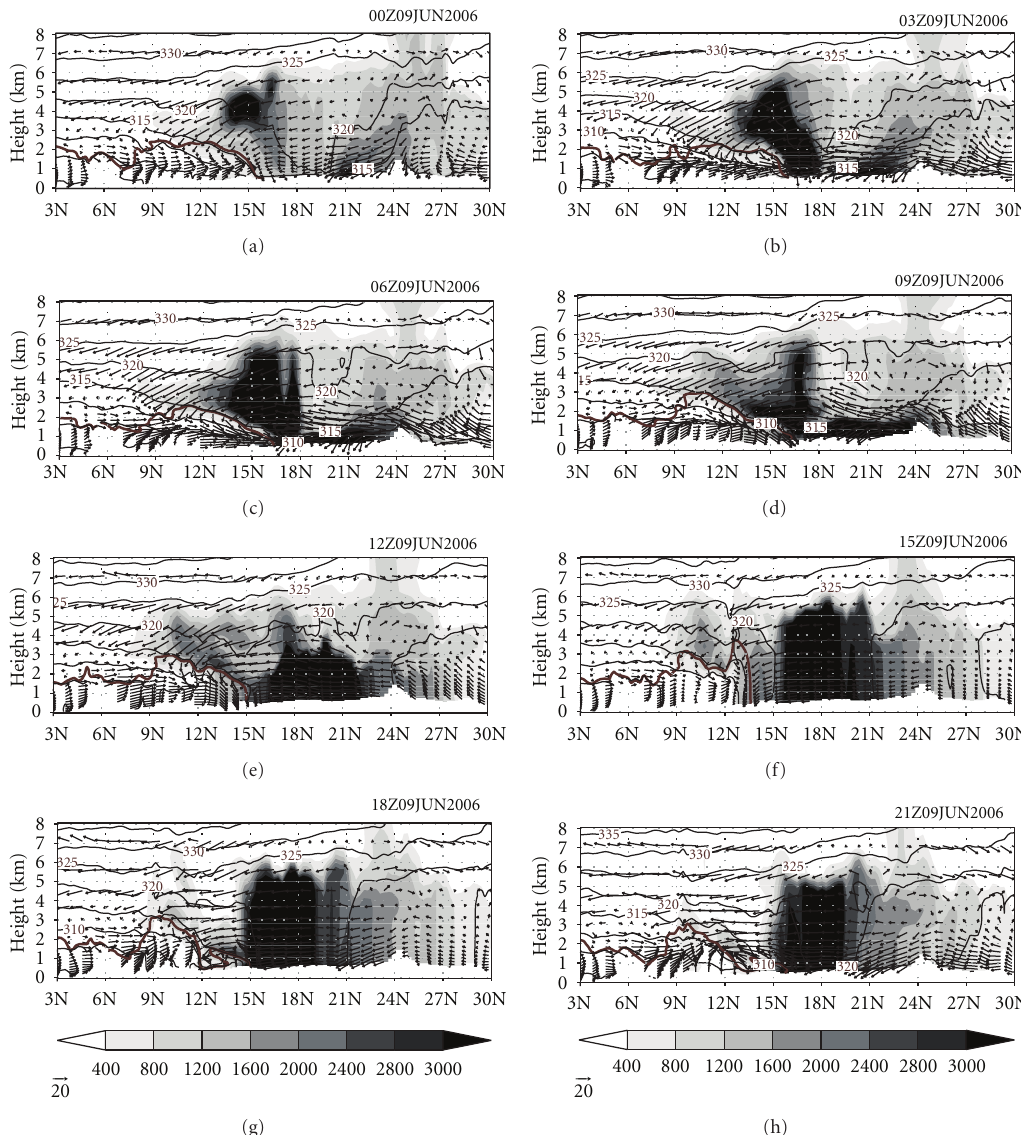
Figure 12: Vertical profiles of atmospheric structure and dust load from WRF-Chem EXP30 (30km). Cross-section is at 10 ◦ E. The figure shows the diurnal cycle on the 9th of June at (a) 0000 UTC, (b) 0300 UTC, (c) 0600 UTC, (d) 0900 UTC, (e) 1200 UTC, (f) 1500 UTC, and (g) 1800